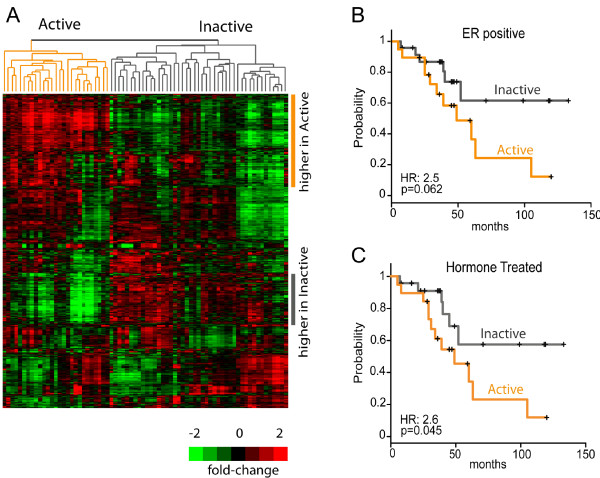
Identification of extratumoral microenvironment subtypes adjacent to breast cancer. (A) Unsupervised clustering dendrogram for 3,518 probes yields two main clusters of non-neoplastic tissues. Cluster 1/Active subtype (left, orange) is associated with high expression of genes involved in cellular movement, inflammatory response, fibrosis and low expression of genes involved in cellular adhesion and differentiation (See also Table 2 for gene ontology analyses). Cluster 2/Inactive Subtype has higher cellular adhesion and differentiation-related gene expression. Kaplan-Meier analysis and univariate Cox Proportional Hazards analysis (to estimate hazard ratios) were conducted comparing overall survival for Active versus Inactive. Results are presented for ER positive patients only (B) and for endocrine-treated patients (C).